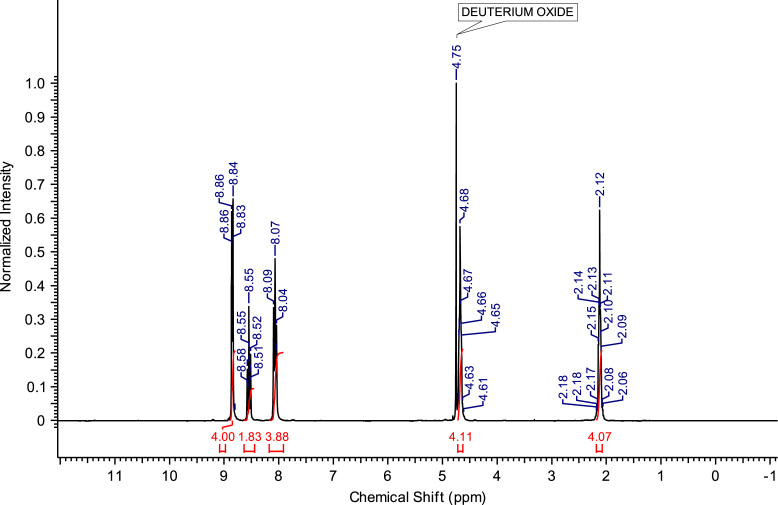
1H NMR spectra of C4(Pyr)2Br2.